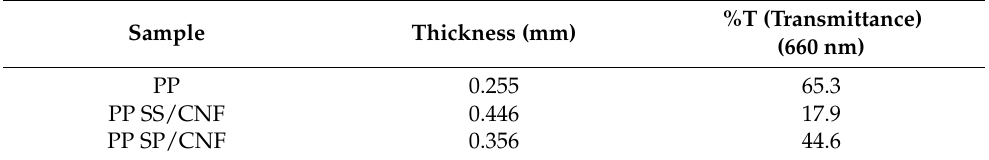
Figure 5. UV–vis transmittance spectra for PP and PP composite. Table 2. Optical properties of PP and PP